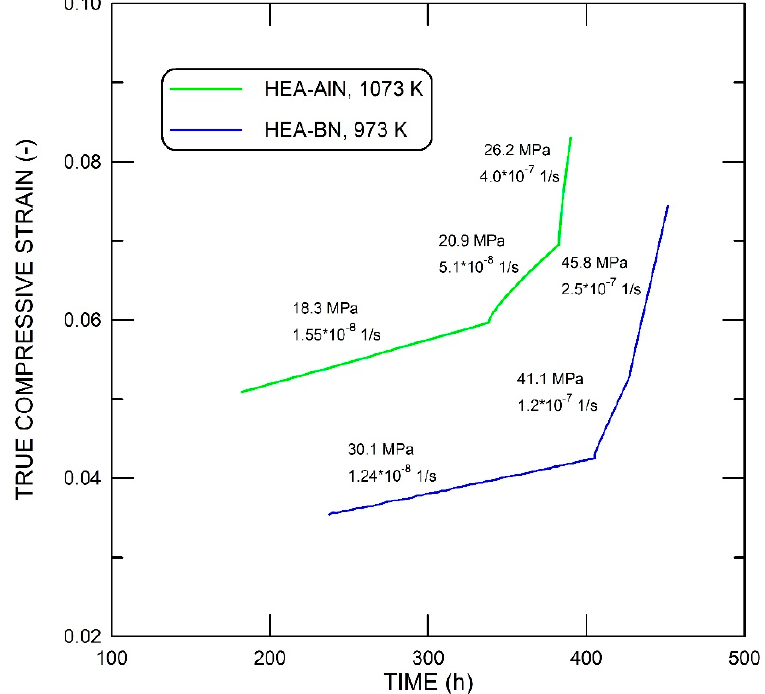
Figure 3. Examples of creep curves at 1073 K (HEA-AlN) and 973 K (HEA-BN). True compressive stress and true compressive strain rates are given for each segment.